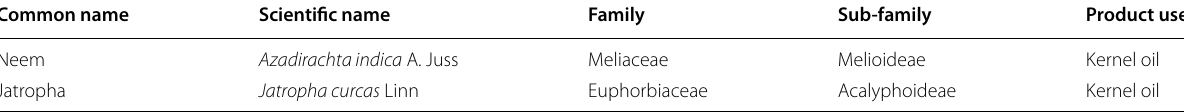
Table 1 Plants evaluated for termiticidal activities against Coptotermes sjostedti (Isoptera: Rhinotermitidae) Common